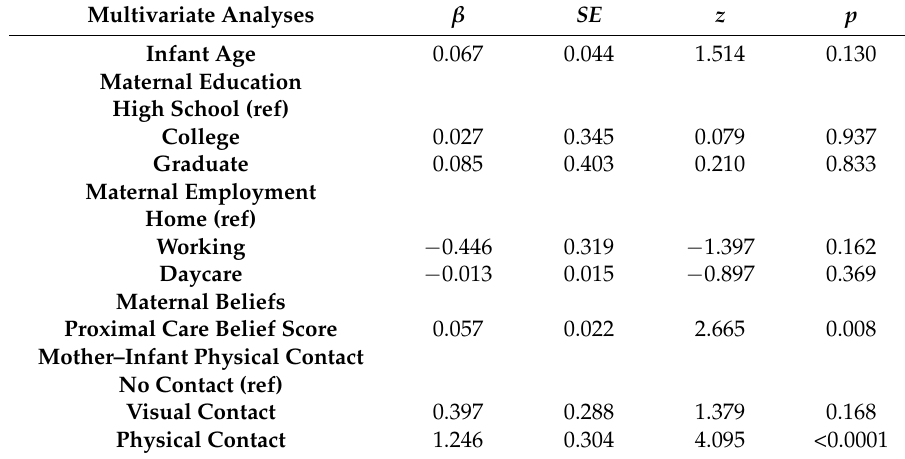
Table 7. Model Predicting Responsiveness to Cues. Fixed effects for the mixed-effects model predicting initiating non-hunger feedings in response to infant comfort (in comparison with adult-determined reasons) in Study